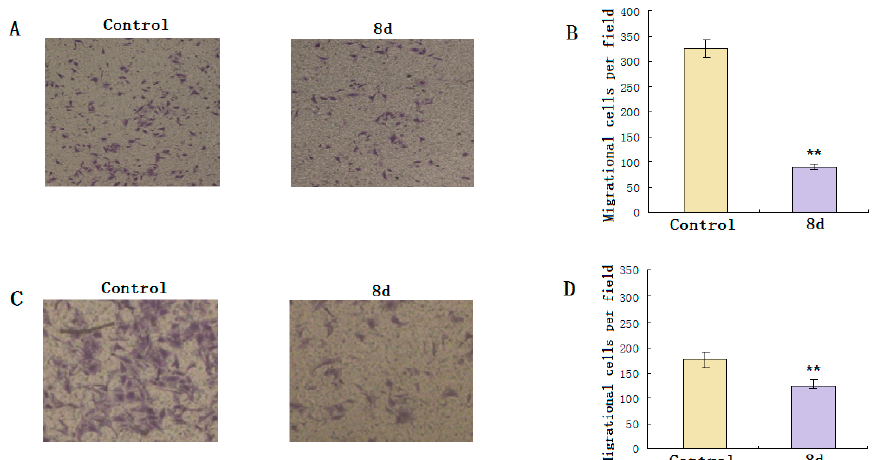
Figure 5. Compound 8d suppressed HepG2 cell invasion and migration (Transwell). ( A ) Cell migration in HepG2 cells before and after the effect of 8d (6 μ M). ( B ) The migratory cell number is presented by bar diagram. ( C ) Cell invasion in HepG2 cells before and after the effect of 8d (6 μ M). ( D ) The number of cells invading to the lower chamber is presented by bar diagram. Data are presented as the mean ± SD of three experiments ** p < 0.01. All images were acquired under a 10× objective lens.